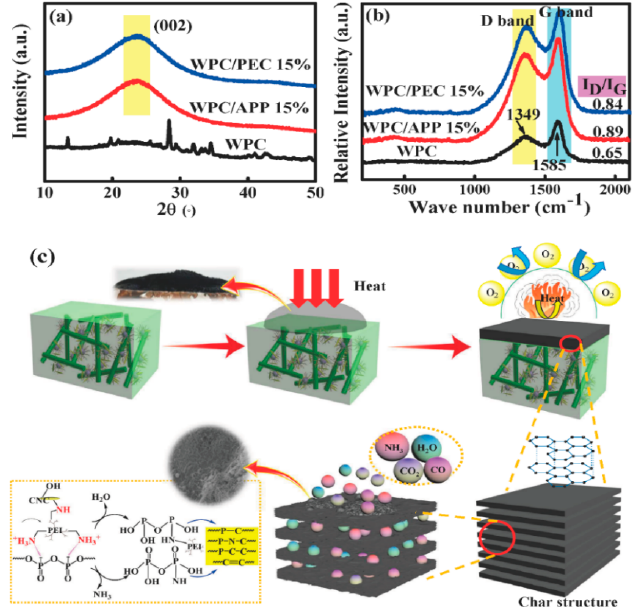
Figure 6. Chemical structure of char residues: XRD ( a ) and Raman spectra ( b ), and possible flame retardancy mechanism of WPC with PEC ( c ).